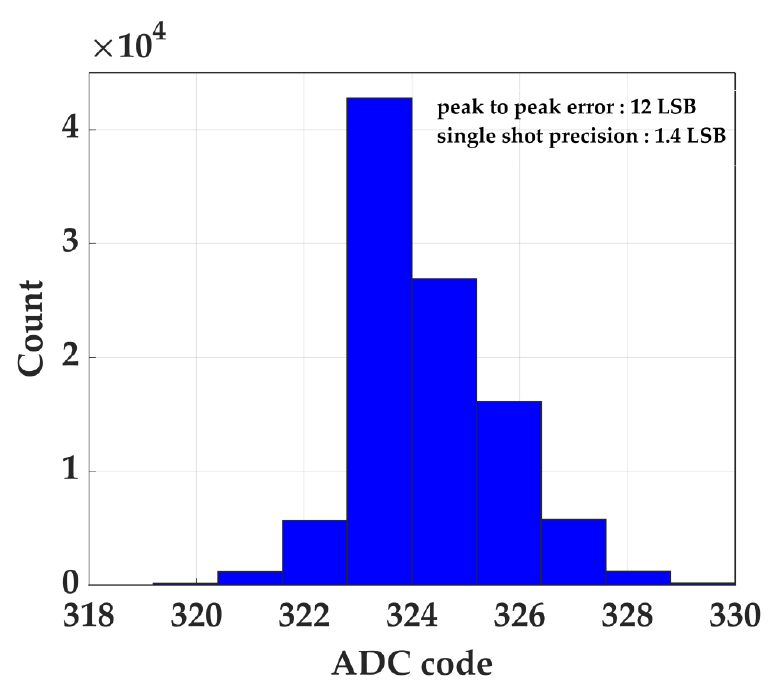
Figure 14. Single-shot measurement obtained by applying a DC voltage.